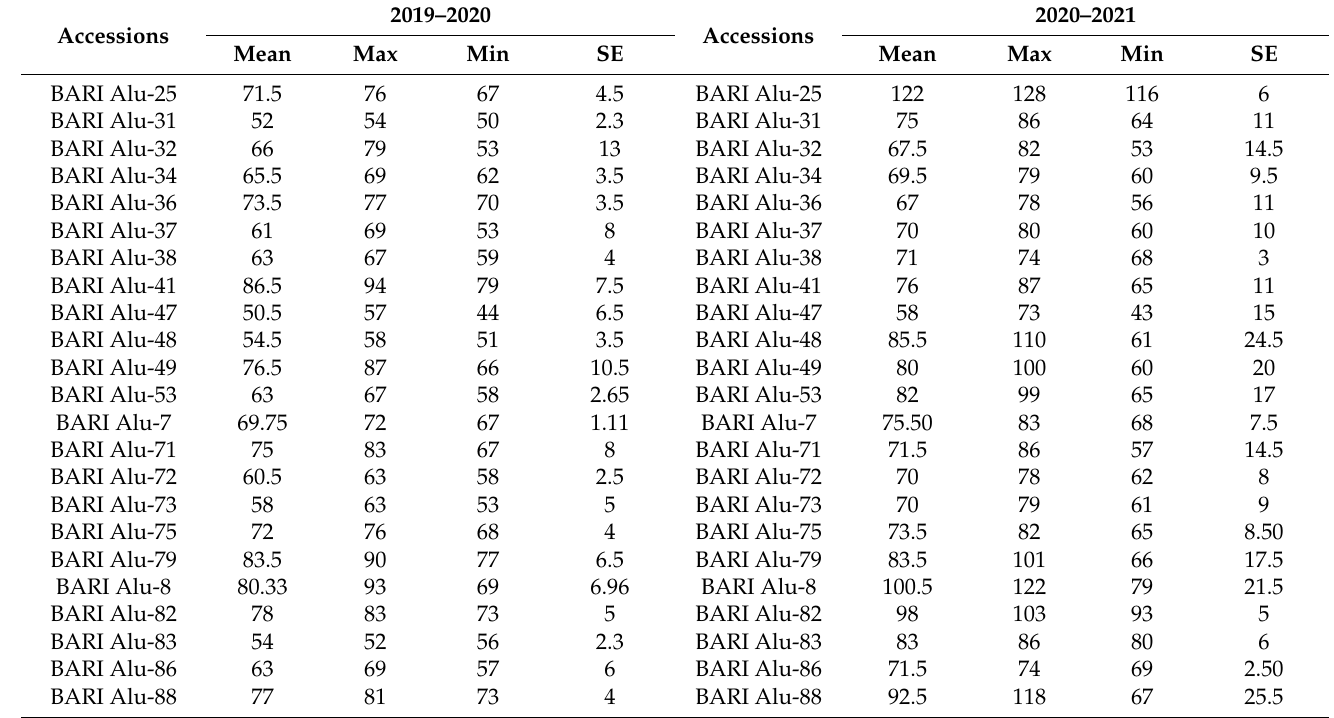
Table 2. Descriptive statistics of days to flowering among BARI potato